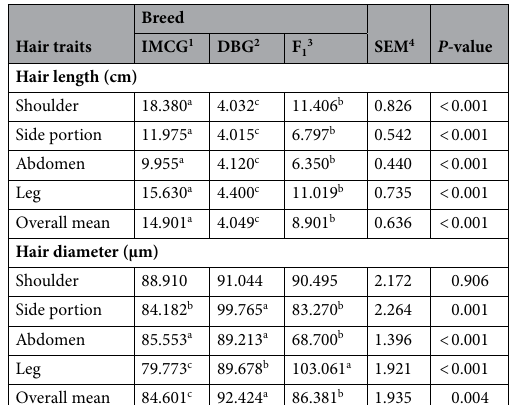
Table 1. Hair length and diameter of IMCG 1 , DBG 2 and their first cross F 13 (mean ± SEM). 1 IMCG; Mongolia Cashmere goat, 2 DBG; Dazu black goat, 3 F 1 ; IMCG DBG cross. 4 SEM; the standard error of the mean. a–c Means with different superscript in the same row are differ ( P < 0.05).